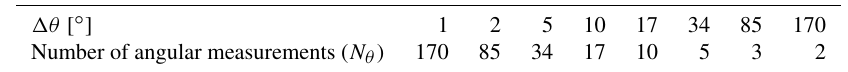
Figure 1. A schematic overview of the implementation of the Bayesian information content analysis. Table 2. Simulated (cid:49)θ values and corresponding number of probed angles for a configuration with evenly distributed sensors and α = 5 ◦ truncation in forward and backward directions.